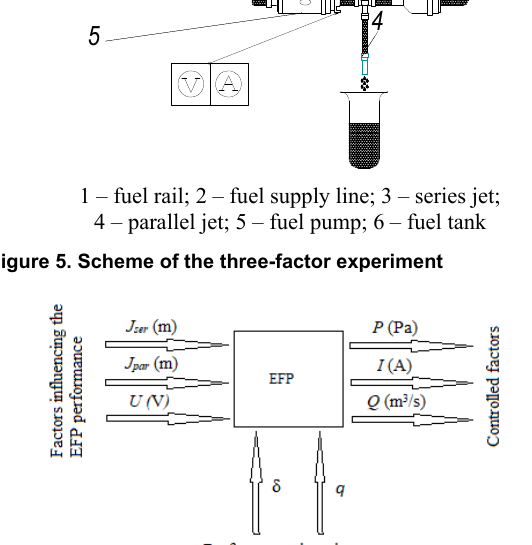
Figure 6. Input and output parameters during the three- factor experiment